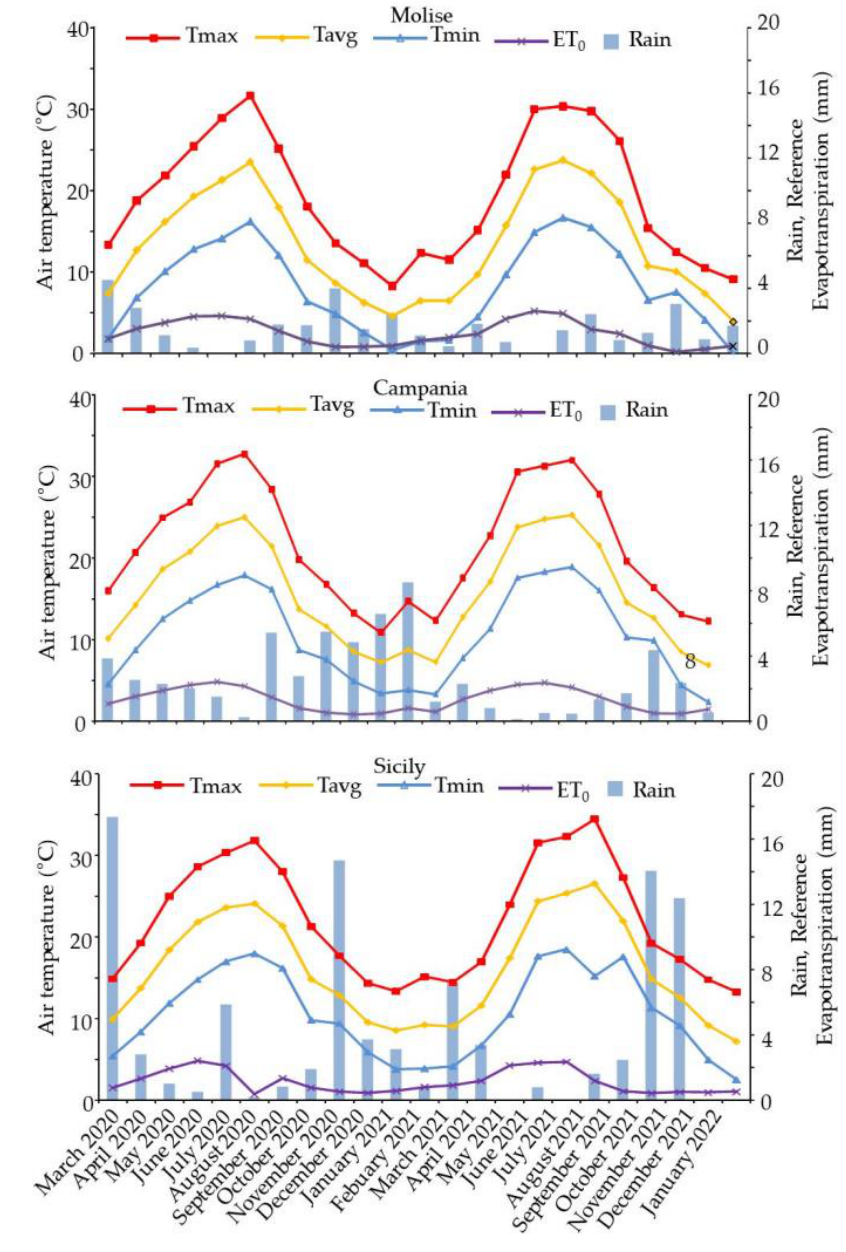
Figure 1. Monthly temperatures ( ◦ C; minimum—Tmin, average—Tavg, and maximum—Tmax), total rainfall (mm), and reference evapotranspiration (ET 0 mm) in the selected vineyards in the Molise (MOL), Campania (CAM), and Sicily (SIC) sites, during the years of experimental report- ing.